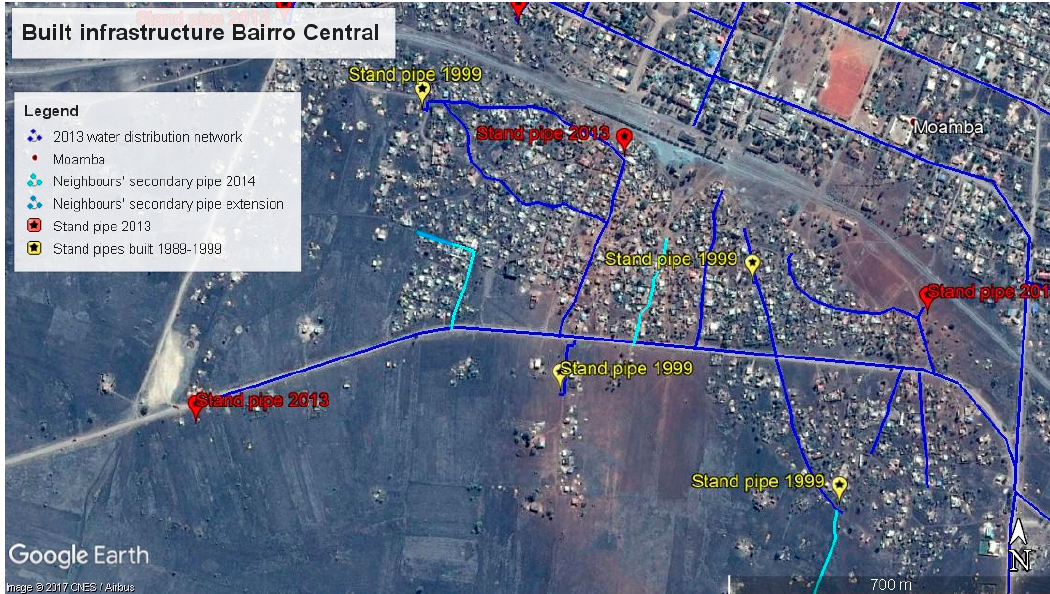
Figure 4. Shape and layout of the built water distribution network in Bairro Central 2017.